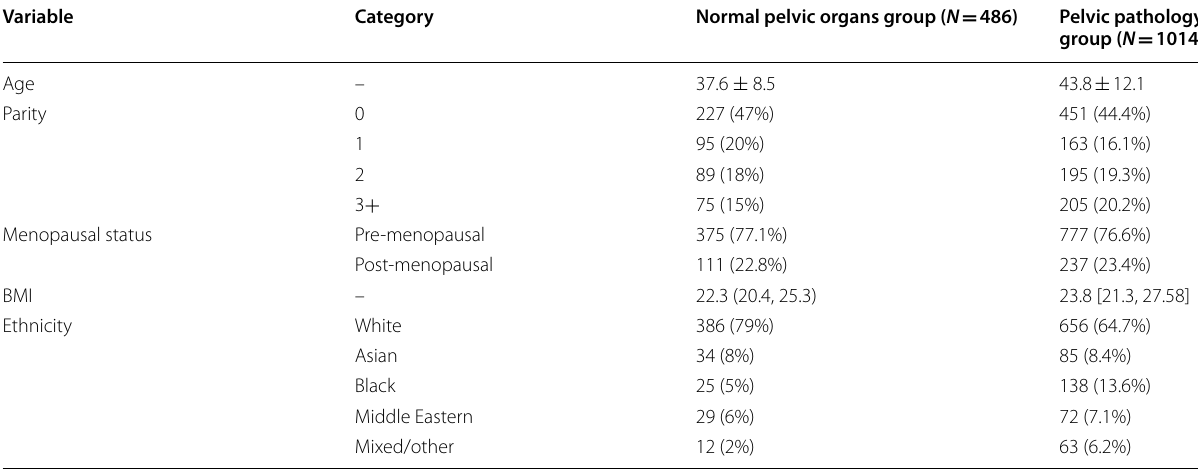
Table 1 Comparisons in demographic information between women with normal pelvic organs and those with pelvic pathology ( N =